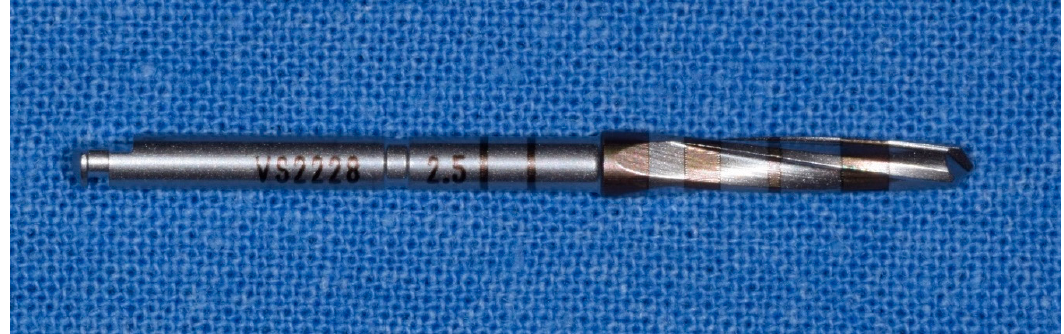
Figure 7. Third cutter with a diameter of 2.3 mm in the method “implant drilling with bone compaction instrumentation technique.”